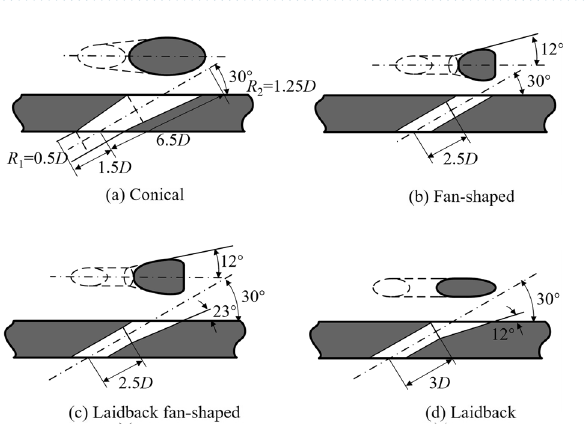
Figure 6. Schematic diagrams of rib turbulators. ( a ) 45°; ( b ) 90°; ( c ) Dimple; ( d ) V.